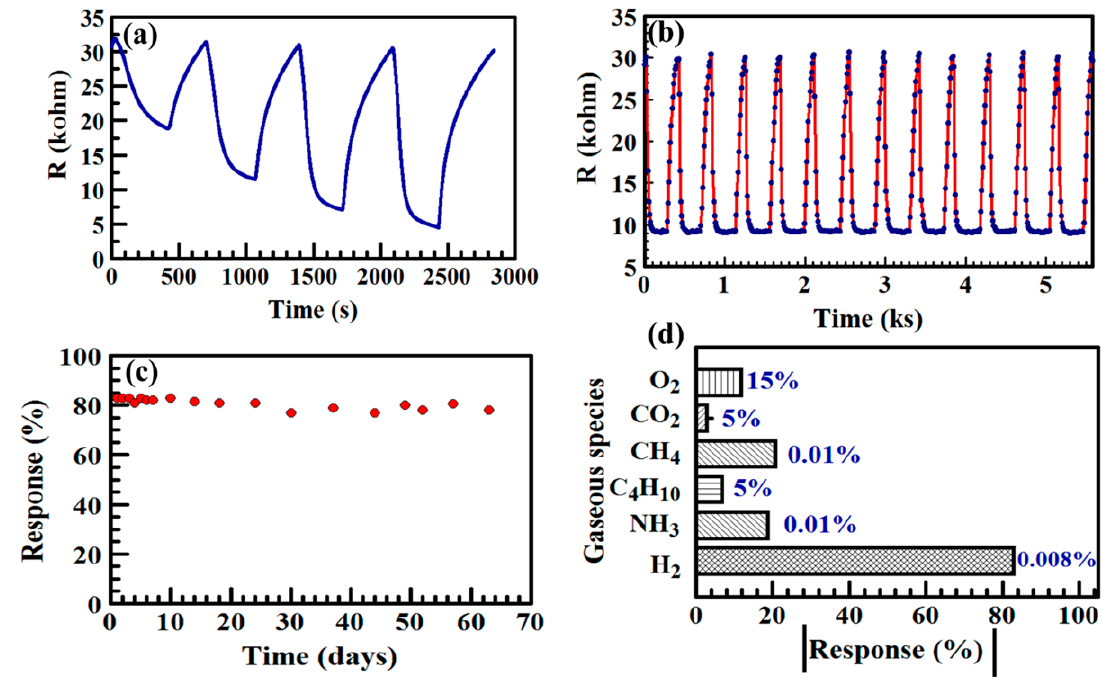
Figure 11. ( a ) Dynamic response curve of different hydrogen concentrations; ( b ) Repeatability measurements of the Au/rGO/ZnO sensor toward 300 ppm of H 2 ; ( c , d ) long term stability, and selectivity test of Au/rGO/ZnO sensor toward 500 ppm of H 2 , tests were realized at room temperature and under UV irradiation [128] . Copyright (2020), with permission from Elsevier.